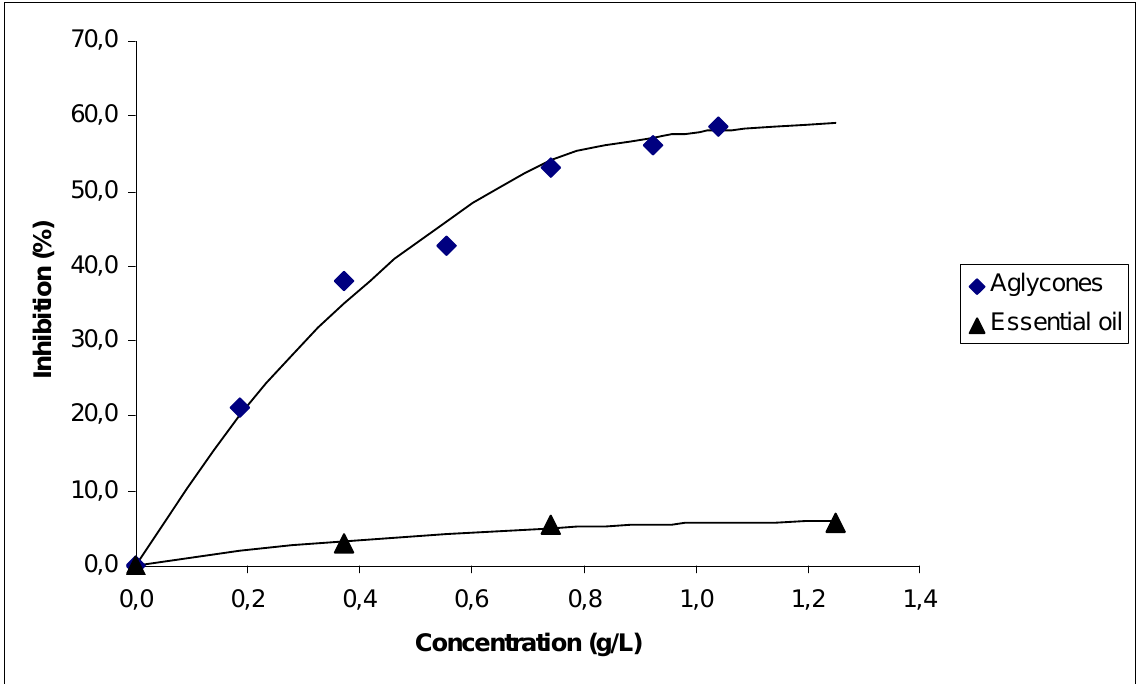
Figure 1. Antioxidant activity of the volatile aglycones and the essential oil from Bosnian pine measured by the DPPH